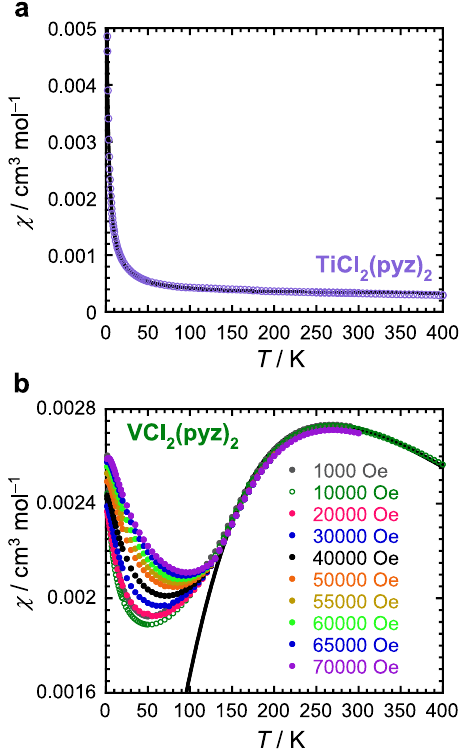
Fig. 3 | Magnetic properties. Temperature dependence of the magnetic suscept- ibility, χ , for a , TiCl 2 (pyz) 2 ( μ 0 H =1.0T) and b , VCl 2 (pyz) 2 (at indicated dc fi elds). Thesolidblacklinesarethebest fi tsoftheexperimentaldatatotheCurie(top)and Curély (bottom) models (see main